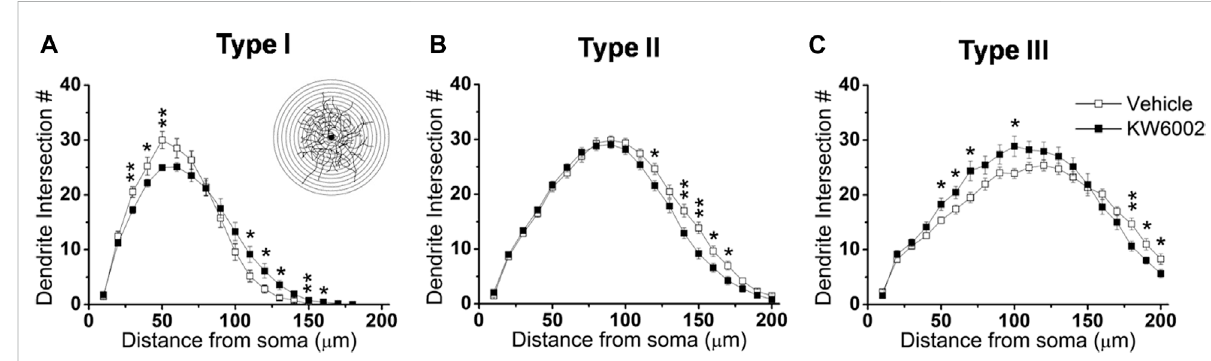
FIGURE 4 The dendritic complexity of RGCs was differentially altered by KW6002 during the development. (A – C) Quantitative Sholl analysis of dendrite intersection numbers in each RGC type from the vehicle-treated and KW6002-treated group during the development. Inset, a series of concentric circles with increasing radius at a 10 μ m step were superimposed on the RGC. Data represent mean ± SEM. * p < 0.05; ** p <